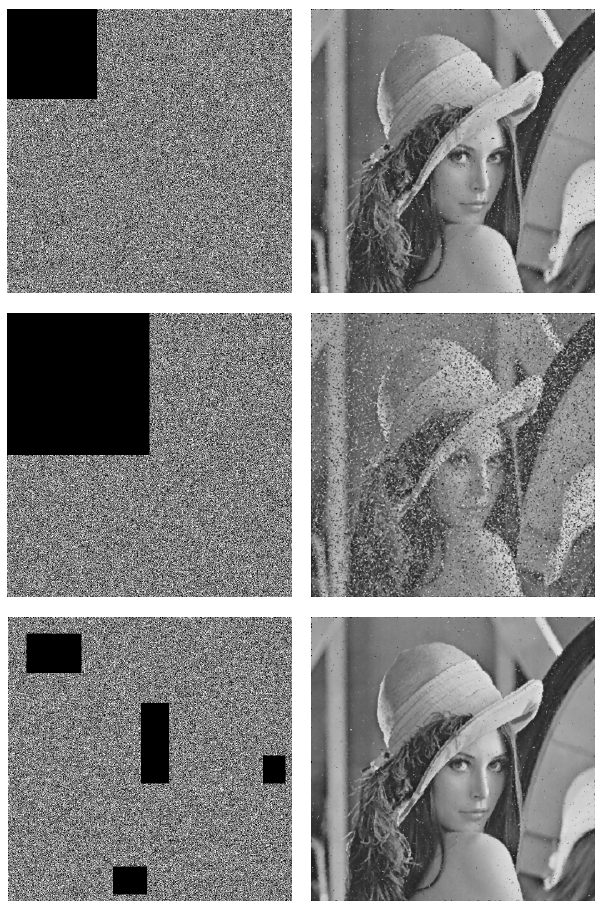
Figure 13. Reconstructed Lena after cropping its corresponding cipher image. ( Top ): 10% crop, ( middle ): 25% crop, ( bottom ): cropped at several